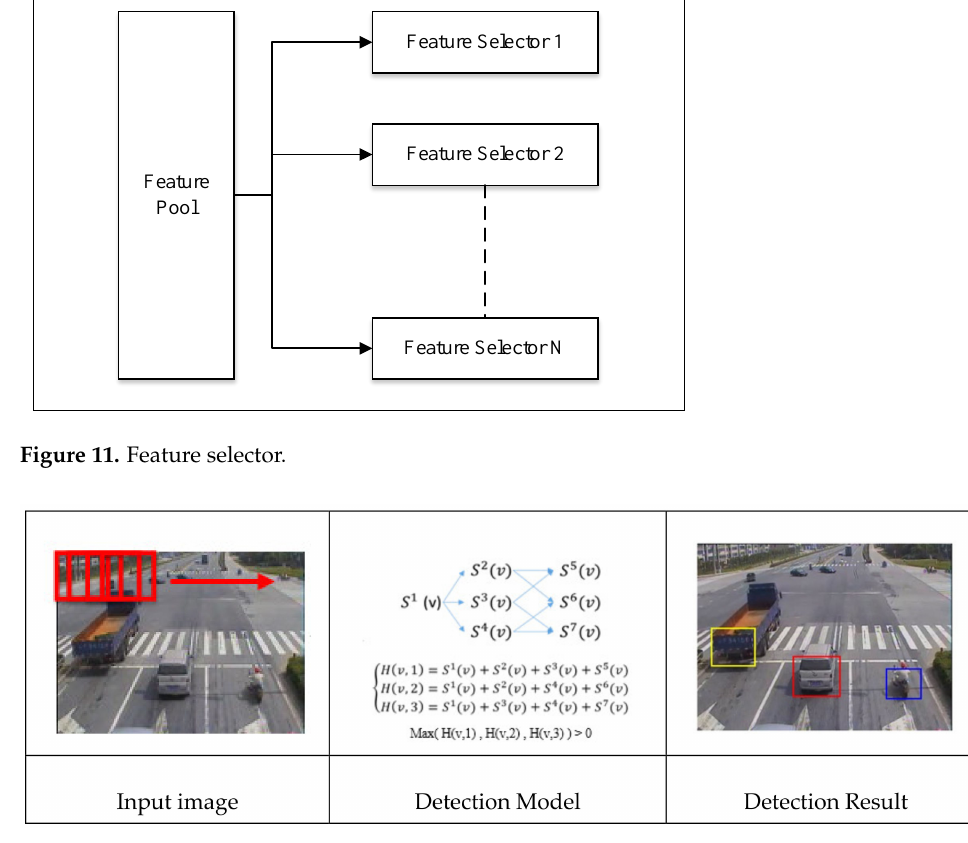
Figure 12. Detection